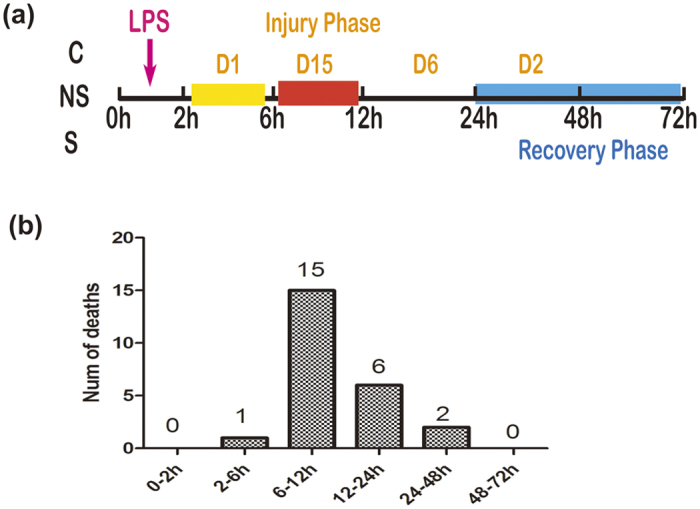
(a) Scheme of the animal experiment protocol in the present study. D1: a rat died from 2 h to 6 h; D15: 15 rats died from 6 h to 12 h; D6: 6 rats died within 12 h to 24 h; D2: 2 rats died from 24 h to 48 h. (b) The LPS group (n = 36) animals were injected with LPS (10 mg/kg) and mortality was monitored for 72 h.